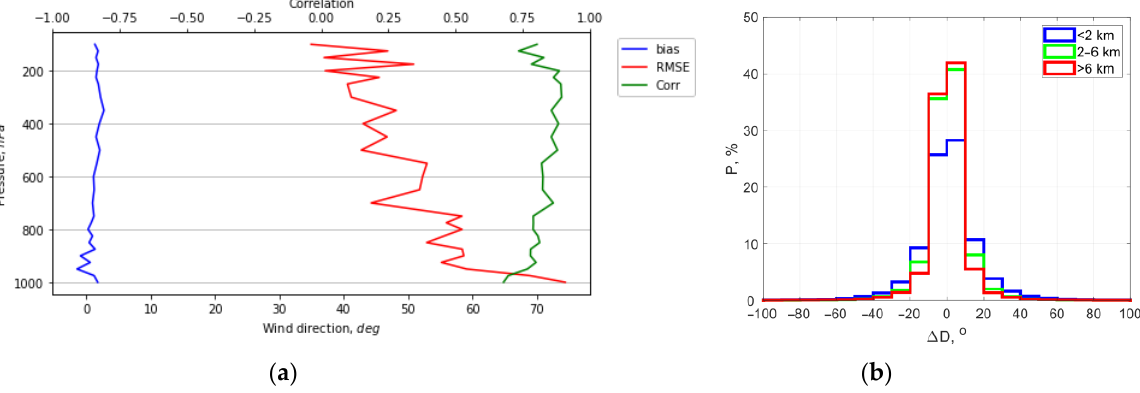
( b ) for the coordinates of the specified aerological stations.